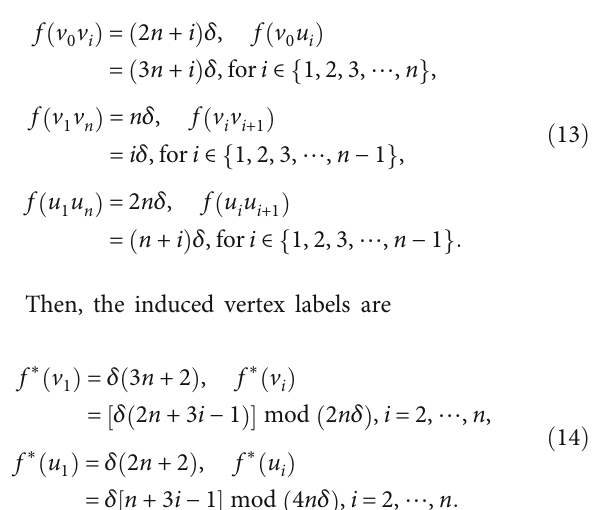
− graceful labeling, W Figure 2: W 13 with edge 5 graceful